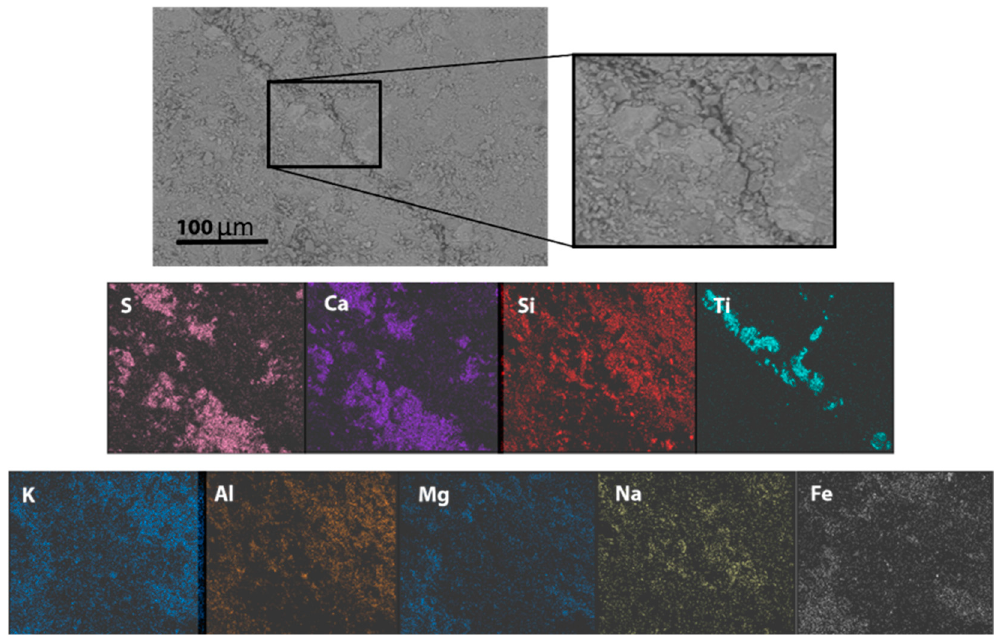
Figure 10. Mapping analysis of the sample heated to 900 °C.